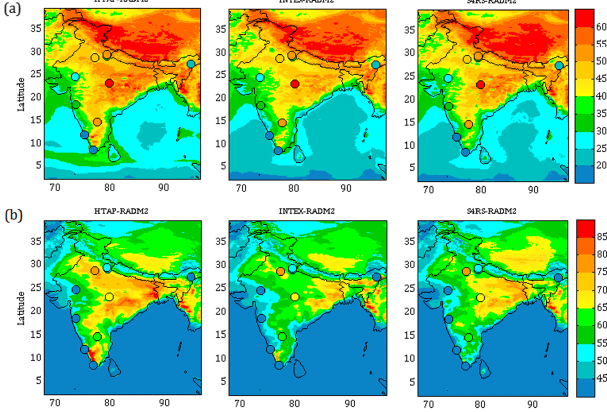
Figure 3. Monthly (April) average surface ozone calculated for (a) 24h and (b) noontime (11:30–16:30IST). The average ozone mix- ing ratios (ppbv) from observations are also shown for comparison on the same colour scale. Note the difference in colour scales in the top and bottom rows.